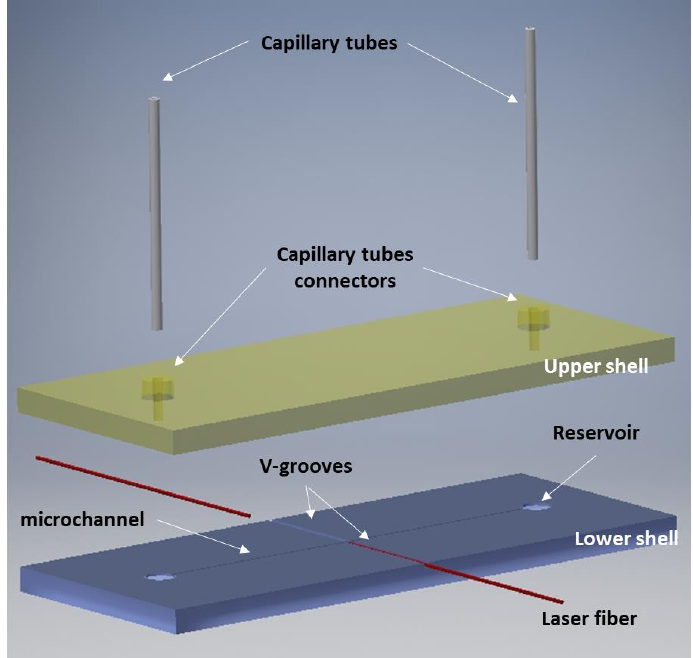
Figure 1. Design of the optical stretcher.